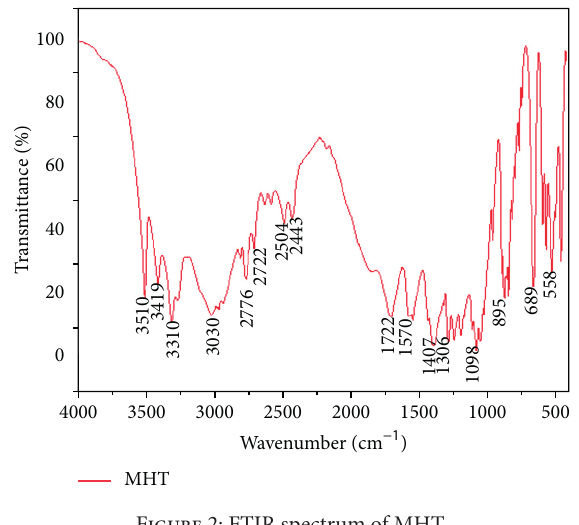
Figure 2: FTIR spectrum of